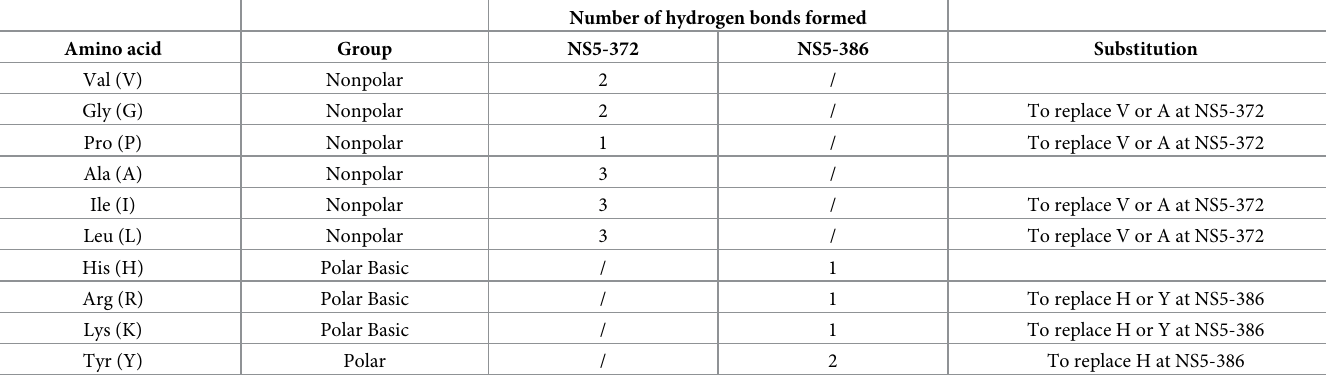
Table 3. Information of amino acids for substitution at NS5-372 and